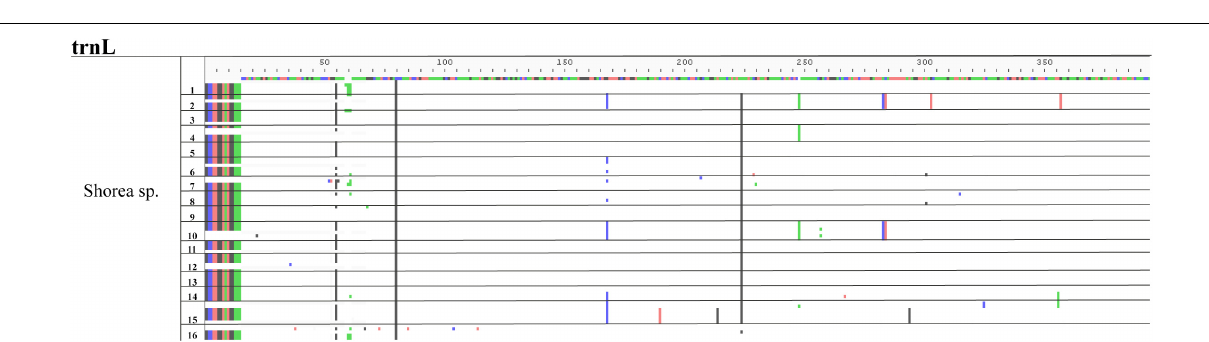
FIGURE 6 | Multiple sequences alignment (MSA) example of species variation from the genus Shorea using trnL marker. The sequence on the top is the alignment consensus of the genus Shorea sp. The different colors below this line indicate the variations within the sequences. The numbers at one side represents the species of this genus. Horizontal lines represent divisions between the different species. Notice that there are no specific variations that could work as specific markers for any given species. A deeper look at these genera allowed important